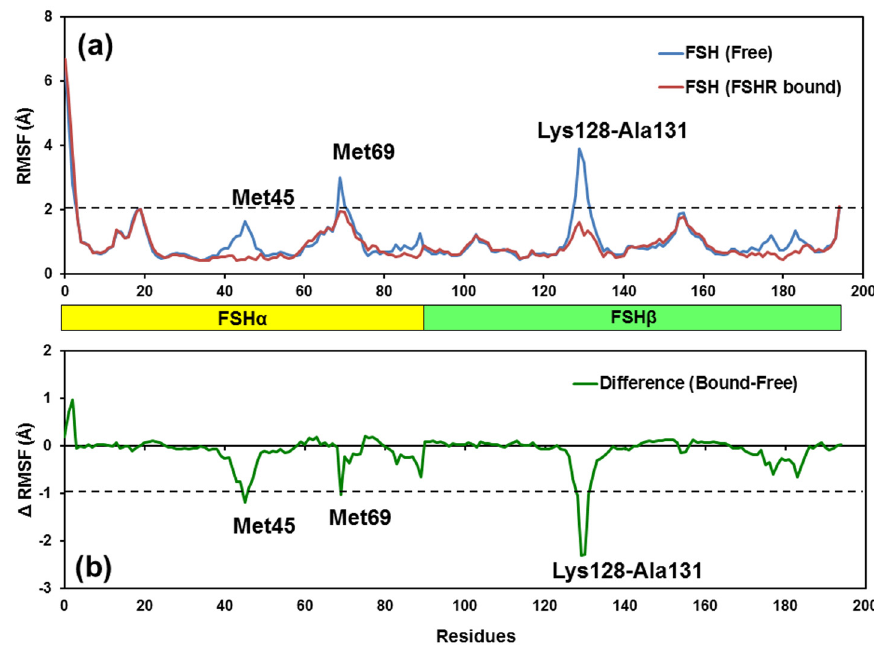
Fig 9. (a) Plot showing RMSF values of C α atoms from MD simulations of free/unbound FSH and FSHr- bound models of FSH. RMSF changes were noted in two regions in the FSH α subunit centered on residues Met45 and Met69 and one region in the FSH β subunit centered on residues Lys128-Ala131. Residues with RMSF changes of at least > 2.0 Å are labeled inside the bars in each subunit. (b) Difference of RMSF values for FSHR-bound FSH and free-FSH models. The residues with absolute difference larger than 1.0 Å are labeled by one cutoff dashed black